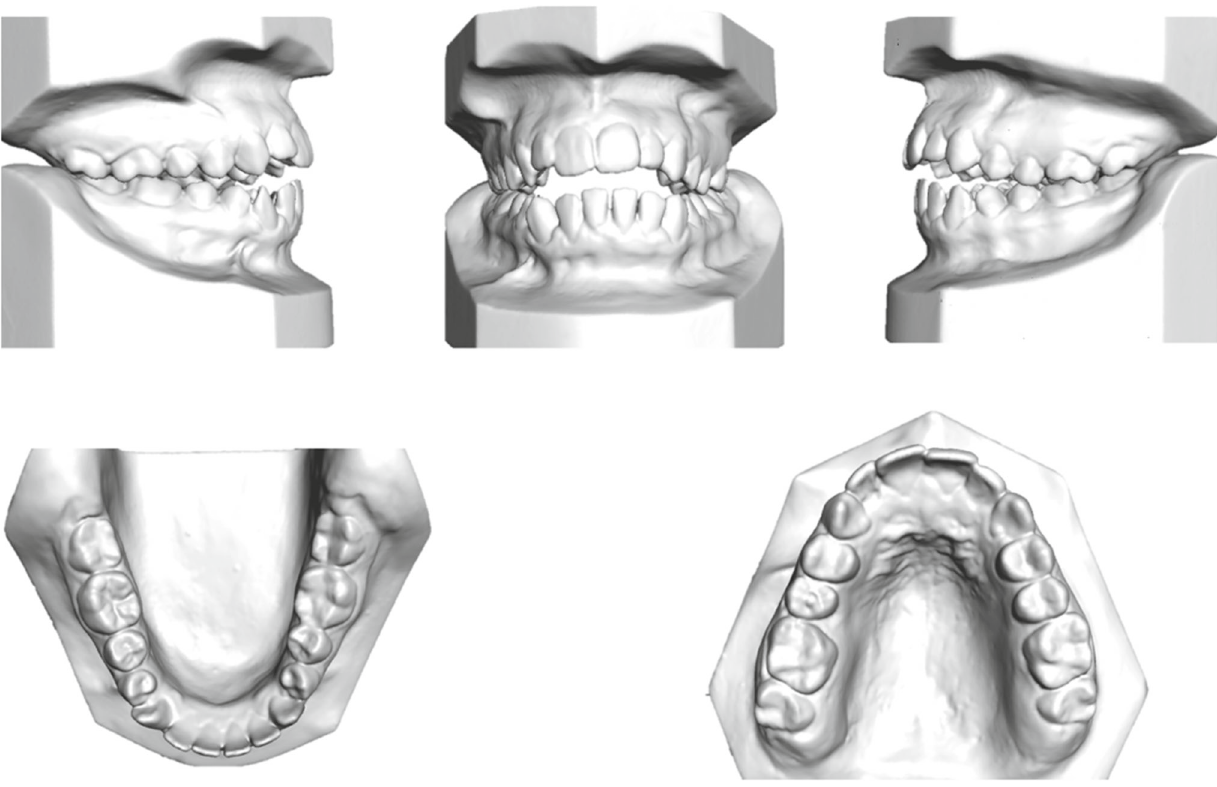
Figure 2: Pretreatment models.